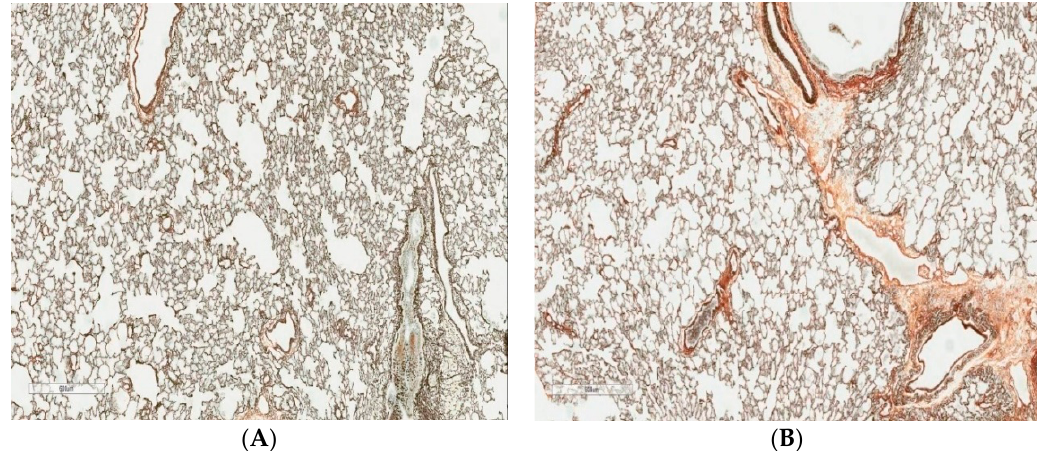
Figure 1. Rat lungs ( A ) after 6-months inhalation exposure to NiO-NPs and ( B ) in the control group of the same exposure period. Gomori’s silver impregnation, magnification × 600.